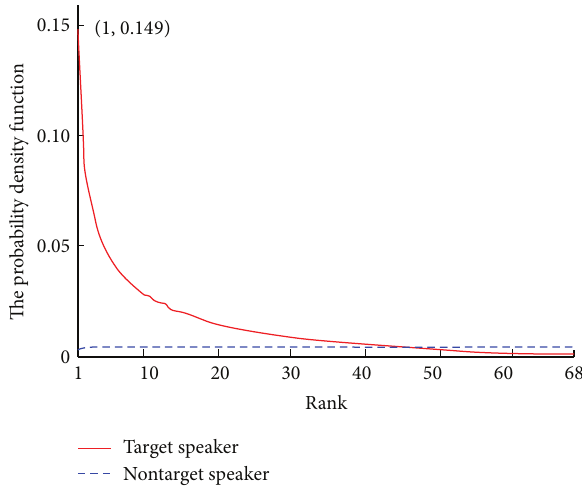
Figure 3: The frame-level score rank’s probability density functions for target speakers and nontarget speakers over 68 subjects in